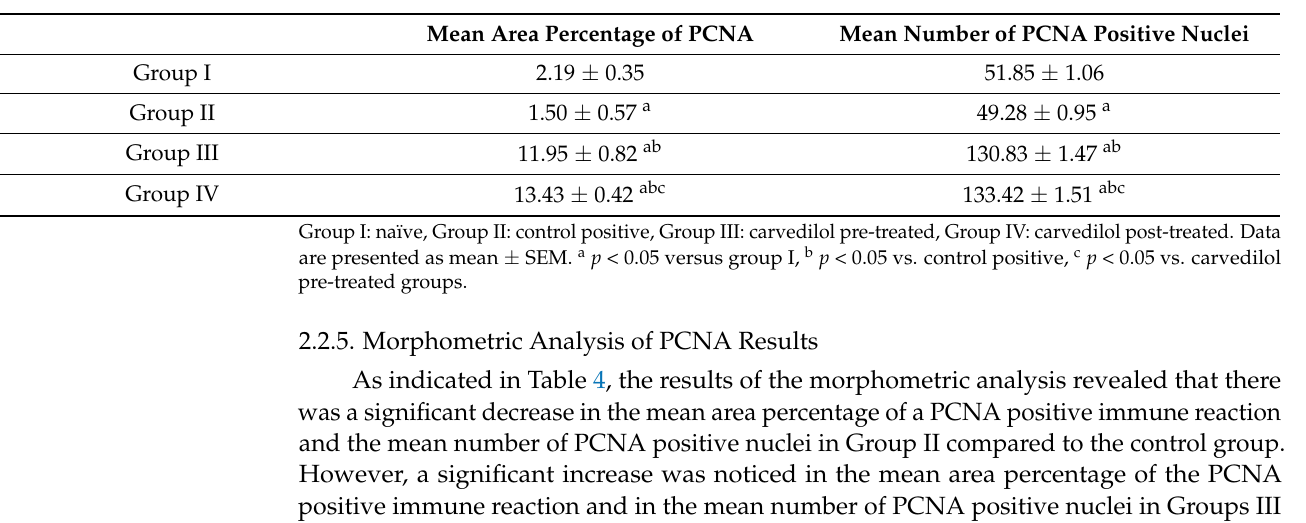
Table 4. Effect of carvedilol on the mean area percentage of PCNA immune reaction and the mean number of PCNA positive nuclei.